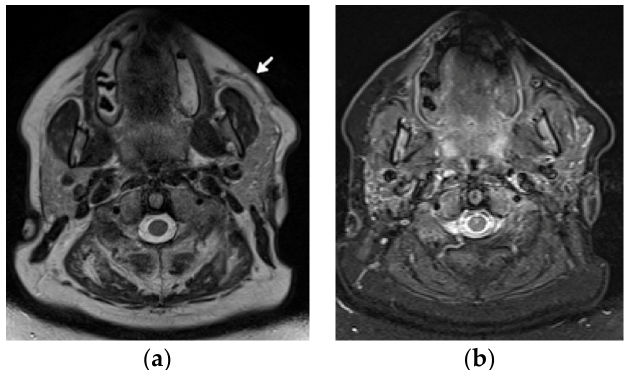
Figure 10. A 48-year-old female patient with systemic lupous erythematosus and a long history of lupus panniculitis and post-inflammatory atrophy of the subcutaneous tissues of the left cheek without active inflammation (arrow), seen in ( a ) the axial T2-weighted time spin echo and ( b ) T2 turbo inversion recovery magnitude MR images.